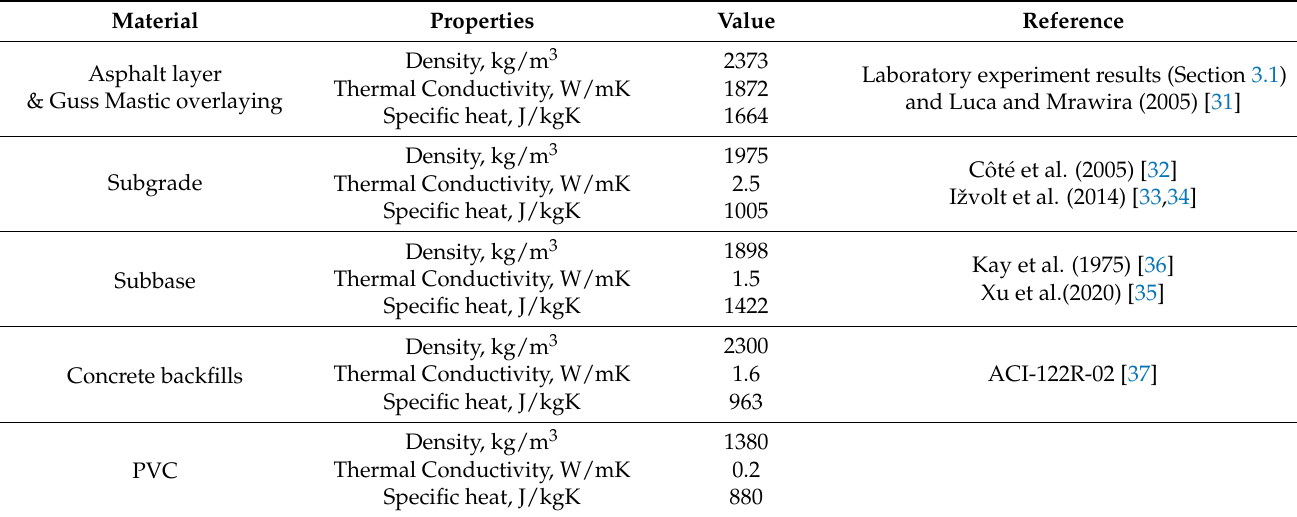
Table 6. Properties of input materials used for simulation